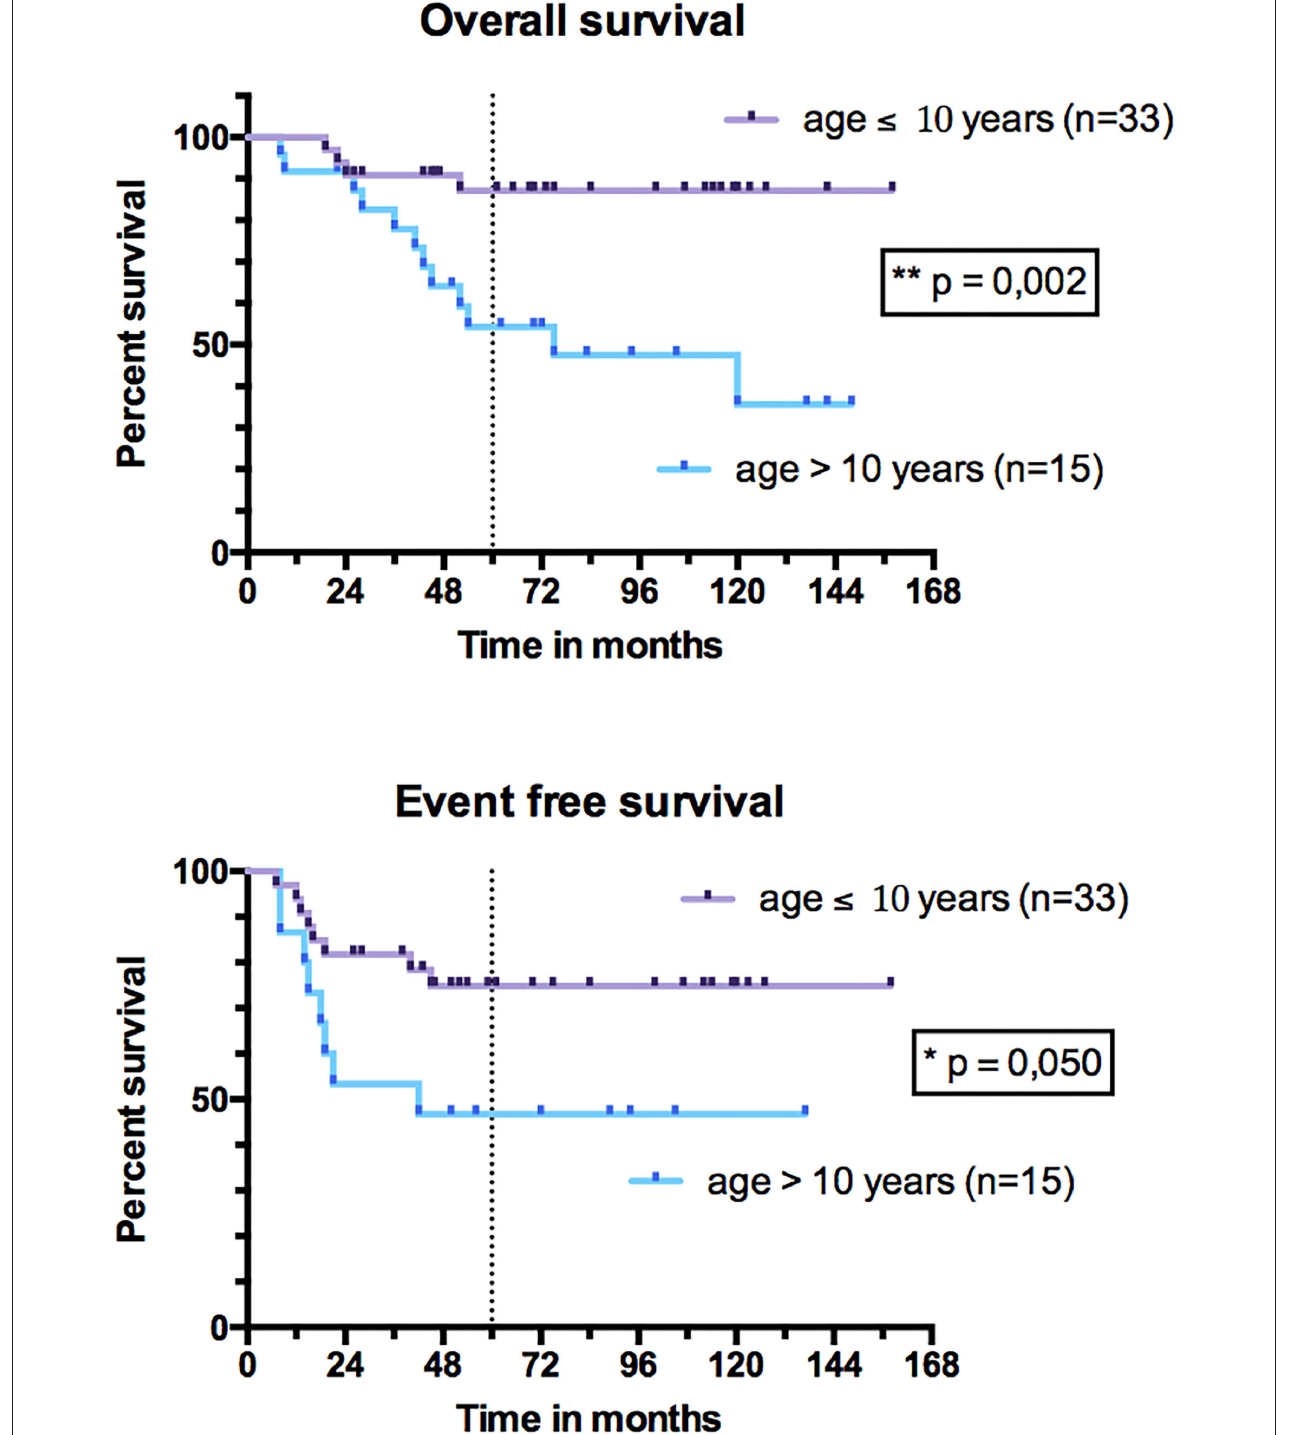
FIGURE 7 | Overall survival and event-free survival of patients under 10 years and patients over 10 years.